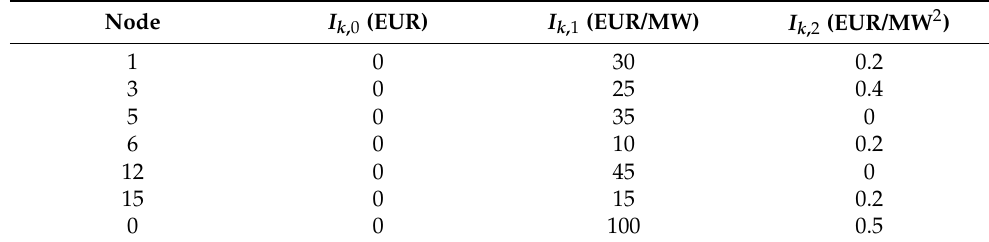
Figure 10. User 3 randomized profile. Table 5. Nodes base price parameters.